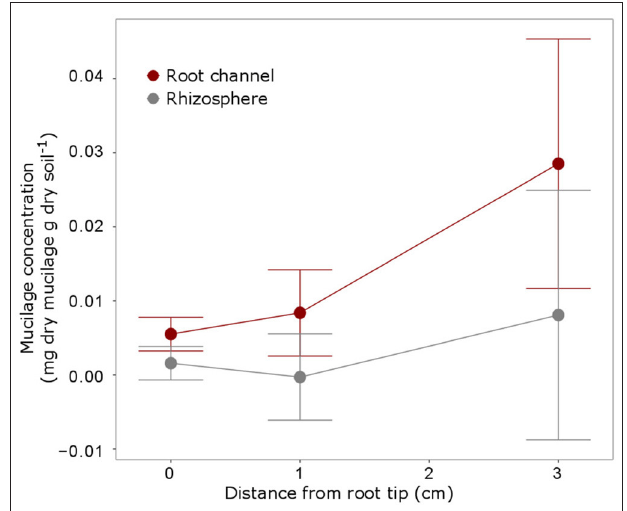
tip and 3cm behind the tip as indicated in Figure 4 . The measurements within the root channel (soil that had been in direct contact with the root) were averaged and compared to the measurements beyond the root channel with was defined as rhizosphere soil [10 measurements ( = 1mm) beyond the root channel border, corresponding to the region defined as “rhizosphere” in Figure 5 ]. The displayed values are the means of 5 replicates (i.e., plants). Variation is given as standard error. Differences between the positions and the soil regions were not significant ( p <